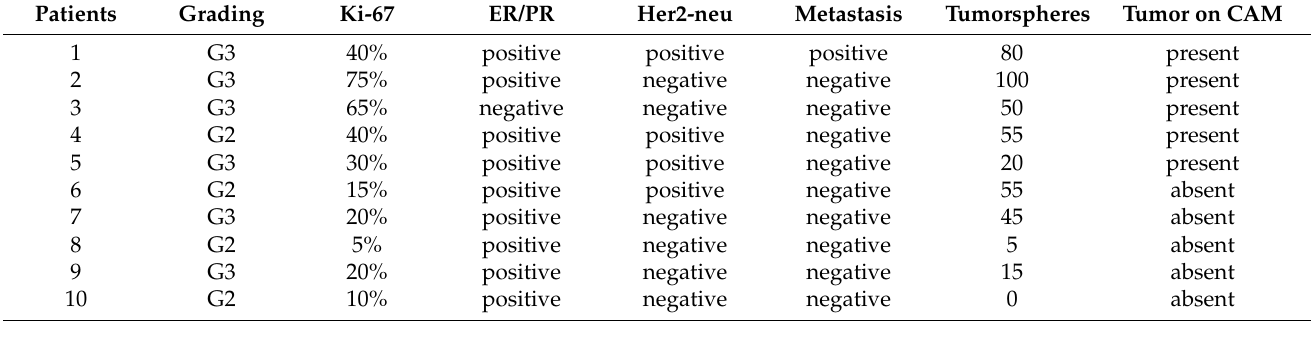
Table 2. Characteristics of patients who underwent CAM experiment.